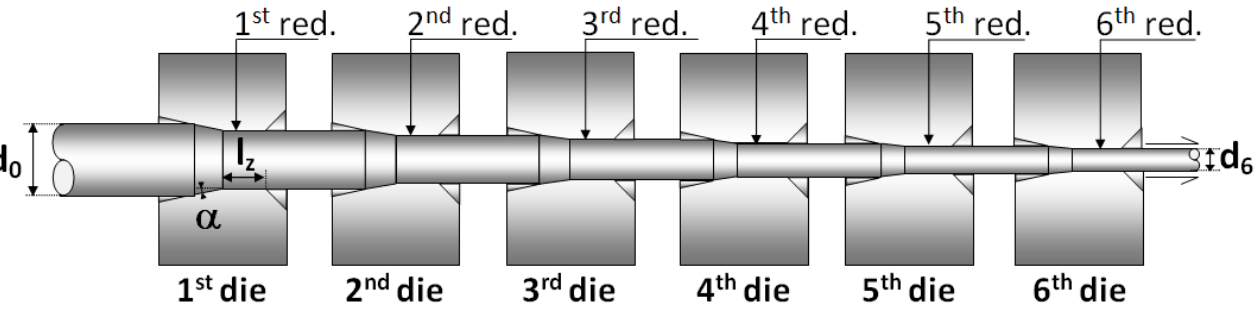
Figure 2. Schematic presentation of the cold drawing process with multiple passes through the dies.